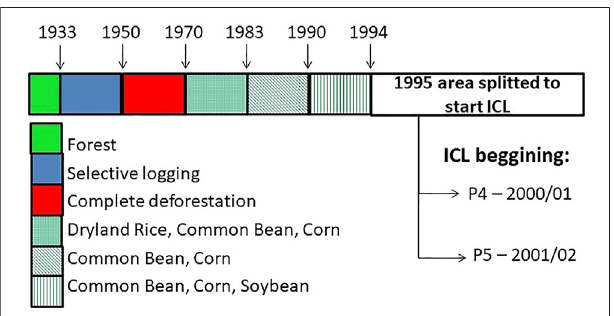
FIGURE 1 | Capivara Farm, State of Goiás, Brazil, site management